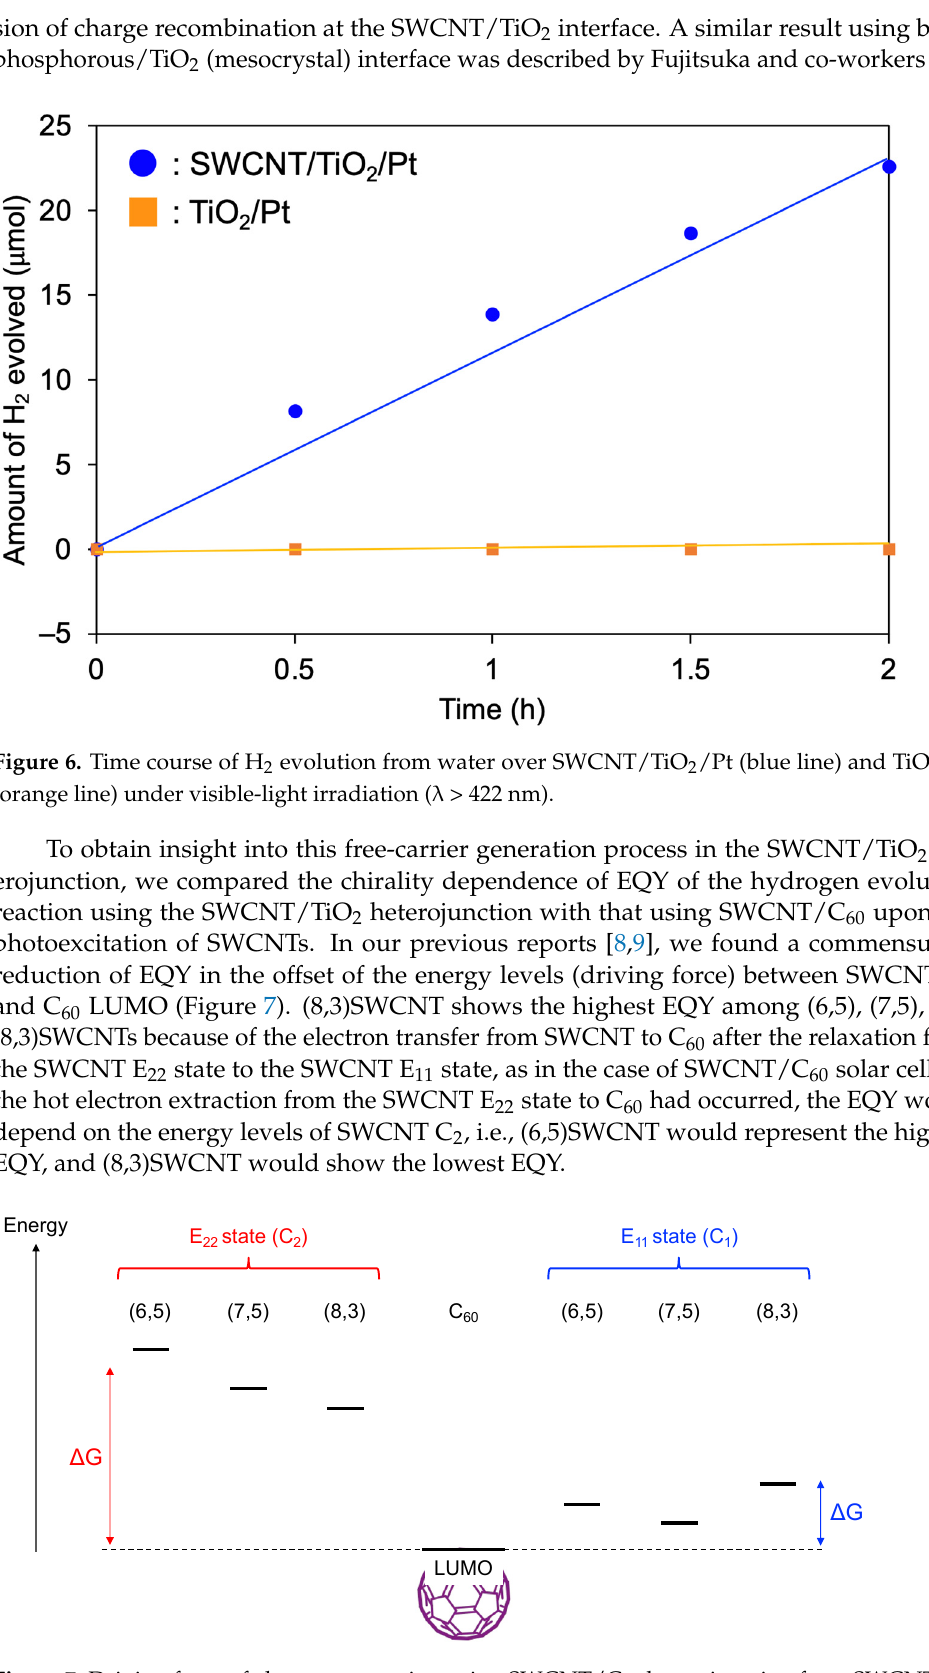
Figure 7. Driving force of electron extraction using SWCNT/C 60 heterojunction from SWCNT E 22 state ( left side) and SWCNT E 11 state ( right side).